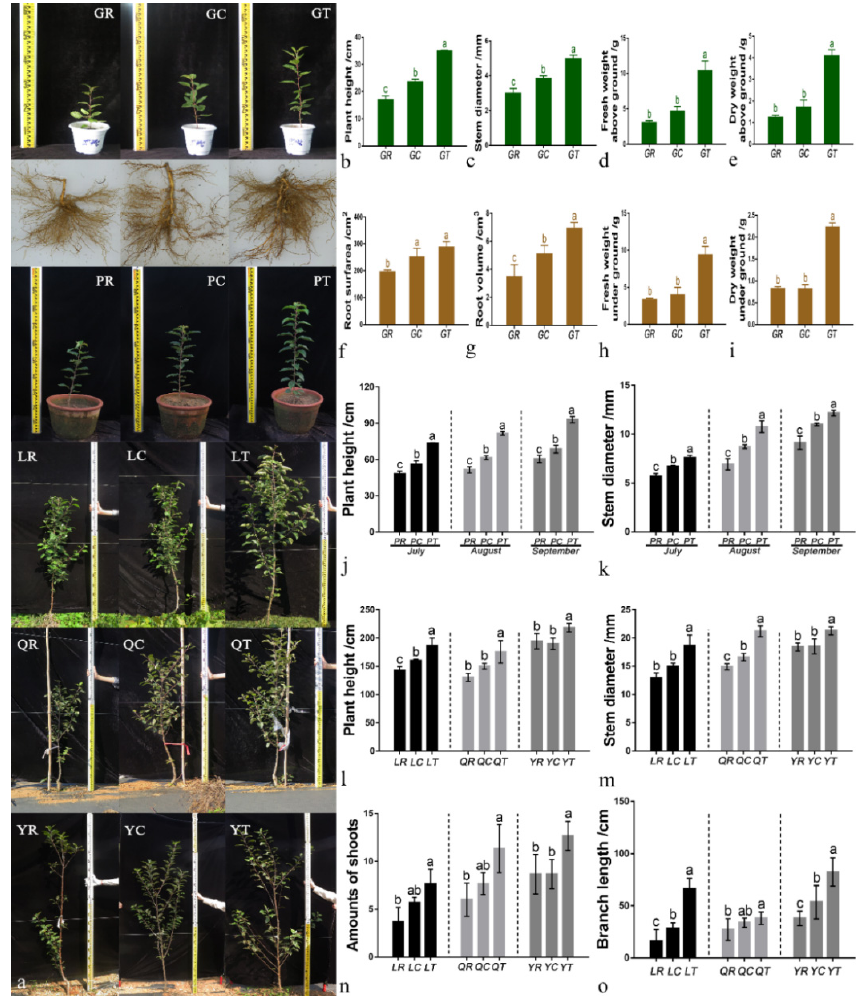
Figure 1. Phenotypes of plants that received different soil treatments in greenhouse, pot, and field experiments ( a ). Plant height ( b ), stem diameter ( c ), aboveground fresh weight ( d ), aboveground dry weight ( e ), root surface area ( f ), root volume ( g ), aboveground fresh weight ( h ), and belowground dry weight ( i ) of M. hupehensis Rehd seedlings in the greenhouse experiment. Plant height ( j ) and stem diameter ( k ) of M. hupehensis Rehd grown in pots from July to September 2021. Plant height ( l ), stem diameter ( m ), branch number ( n ), and branch length ( o ) of young apple trees in the field experiment in October 2021. GR, control replant soil in the greenhouse experiment; GC, replant soil with blank carrier in the greenhouse experiment; GT, replant soil with 6S-2 fertilizer in the greenhouse experiment; PR, control replant soil in the pot experiment; PC, replant soil with blank carrier in the pot experiment; PT, replant soil with 6S-2 fertilizer in the pot experiment; LR, control replant soil in Laizhou; LC, replant soil with blank carrier in Laizhou; LT, replant soil with 6S-2 fertilizer in Laizhou; QR, control replant soil in Qixia; QC, replant soil with blank carrier in Qixia; QT, replant soil with 6S-2 fertilizer in Qixia; YR, control replant soil in Yiyuan; YC, replant soil with blank carrier in Yiyuan; YT, replant soil with 6S-2 fertilizer in Yiyuan. The displayed data were presented as mean ± SE (standard error). Different lowercase letters in the same column indicate a significant difference at p ≤ 0.05 level by Duncan’s new multiple range test. The same treatment names and statistical tests were used in subsequent figures.